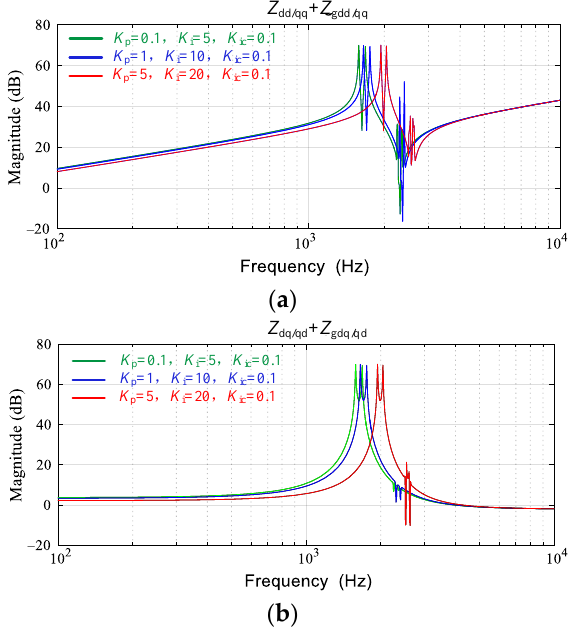
Figure 10. Impedance Bode plots under different parameters of the capacitor voltage regulator. ( a ) Impedance characteristics on the main diagonal. ( b ) Impedance characteristics on the subdiagonal.